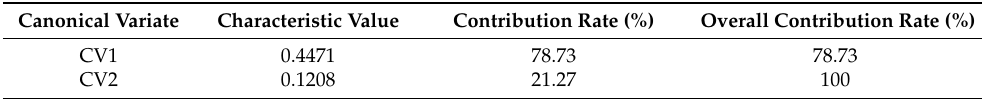
Table 4. The characteristic value, contribution rate and overall contribution rate of canonical variate analysis of three groups (C1, C2 and C3) in S 2 generation derived from an allohexaploid Brassica hybrid